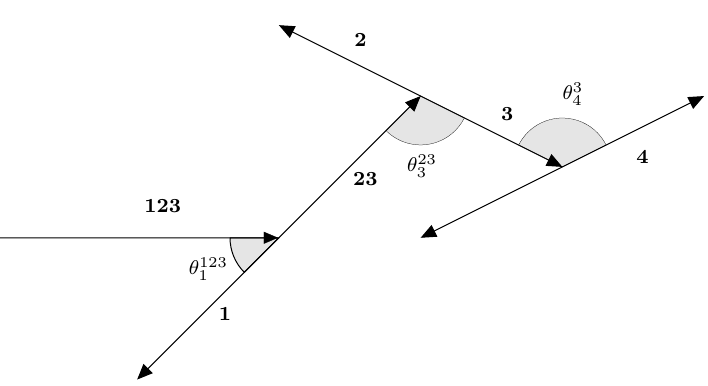
Figure 1. Schematic representation of the t (cid:22) t(cid:30) decay chain and angles between the di(cid:11)erent systems and decay products.